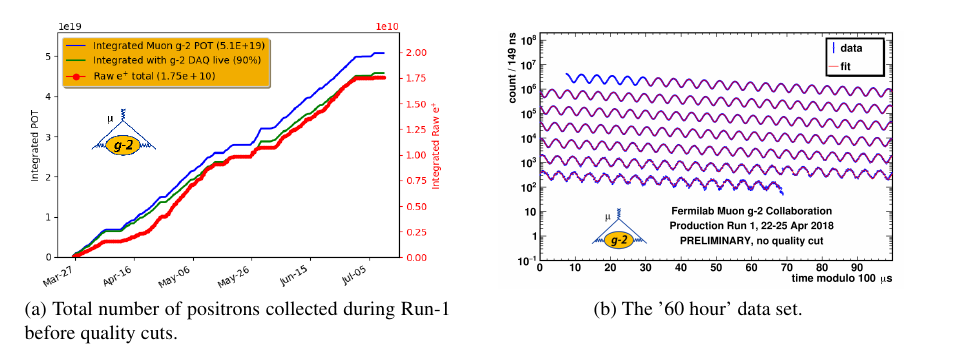
Figure 4: Data collected during Run-1 of the Muon g − 2